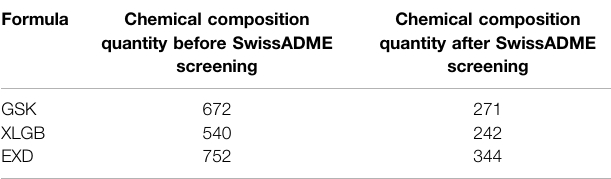
TABLE 2 | The number of active components before and after SwissADME screening in GSK, XLGB, and EXD. Formula Chemical composition quantity before